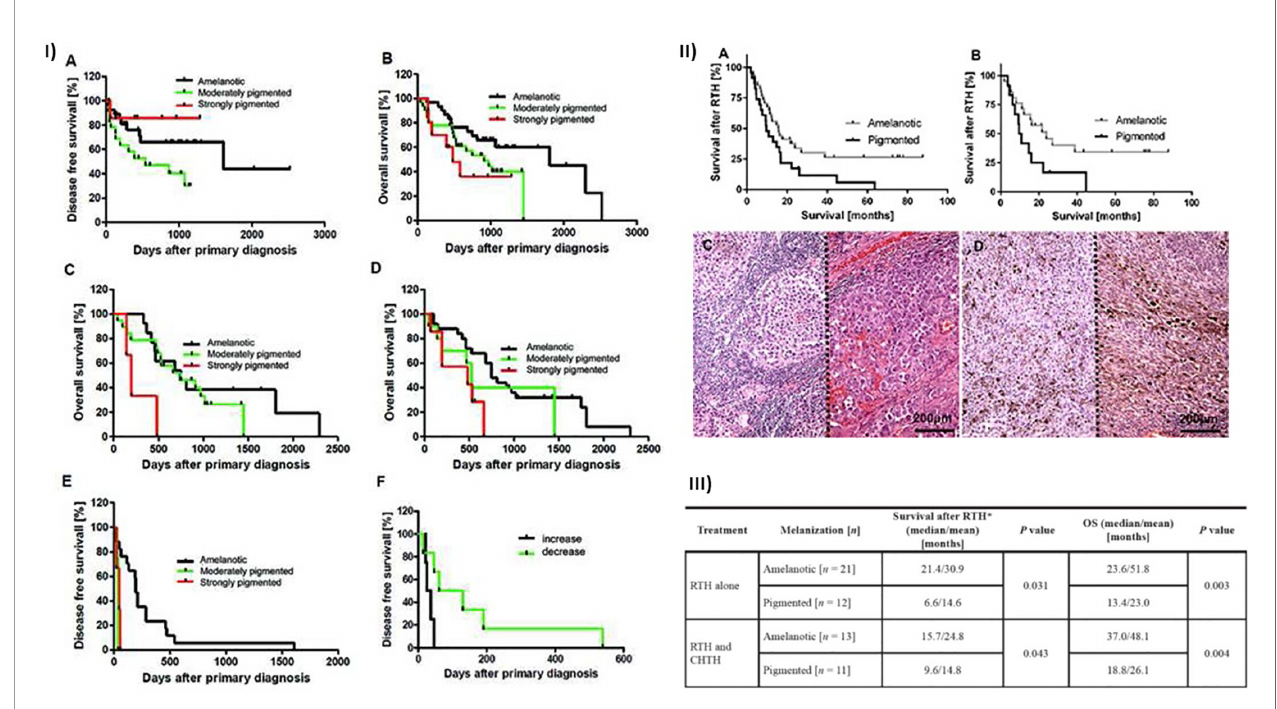
FIGURE 4 | Relationship between melanization and survival of cutaneous melanoma patients. (I) Correlation between melanin level and disease-free (DFS) and overall (OS) survival in patients with melanomas (n = 73). Reproduced from (226) with a permission from the publisher. (A) DFS and (B) OS curves in all melanoma patients (localized [n = 37]) and metastatic disease [n = 36]) strati fi ed according to melanin content. OS curves of primary metastasizing melanomas [ (C) ; c 2 = 7.554, p = 0.0229; amelanotic vs. strongly pigmented: c 2 = 6.113, p = 0.0134, c 2 = 6.570, p = 0.0104; amelanotic vs. moderately pigmented: c 2 = 5.656, p = 0.0174] and lymph node metastases [ (D) ; c 2 = 3.972, p = 0.0463; amelanotic vs. strongly pigmented: c 2 = 6.603, p = 0.0102] strati fi ed according to melanin content. (E) DFS curves of melanoma lymph node metastases strati fi ed according to melanin content in metastatic tumors ( c 2 = 11.43, p = 0.0033; amelanotic vs. moderately pigmented: c 2 = 10.23, p = 0.0014; amelanotic vs. strongly pigmented: c 2 = 7.812, p = 0.0052). (F) DFS curves of metastatic melanomas strati fi ed into groups with decreased or increased melanin content in metastases relative to primary melanomas (log-rank test, c 2 = 4.071, p = 0.0436). (II) Survival time of melanoma patients after radiotherapy (RTH). (A) Survival of melanoma patients received both RTH and CHTH or only RTH ( n = 57; c 2 = 4.62, p = 0.03). (B) Survival of melanoma patients received only RTH treatment (n = 33; c 2 = 4.33, p = 0.04). Melanomas were strati fi ed according to melanin level in melanoma metastases. Representative amelanotic (C) and pigmented [ (D) ; two cases separated with dotted line] lymph node melanoma metastases. Scale bars = 200 µm. Reproduced from (227) with a permission from the publisher. (III) Survival after RTH and OS in melanoma patients with pigmented and amelanotic metastatic melanomas that were con fi rmed histologically, and who received radiotherapy (n = 57). CTHT, chemotherapy; RTH, radiotherapy; OS, overall survival time from primary diagnosis to the end of observation or death of patient, *survival time from the end of radiotherapy treatment to the end of observation or death of patient. Reproduced from (227) with a permission from the